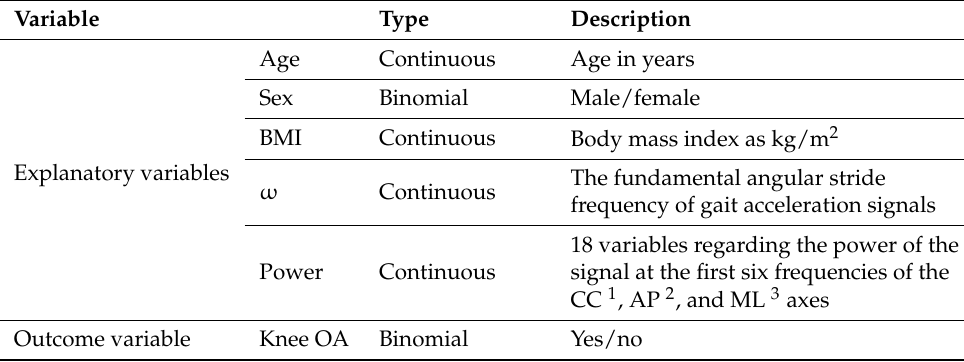
Table 1. The description of explanatory and outcome variables included in the logistic LASSO regression.